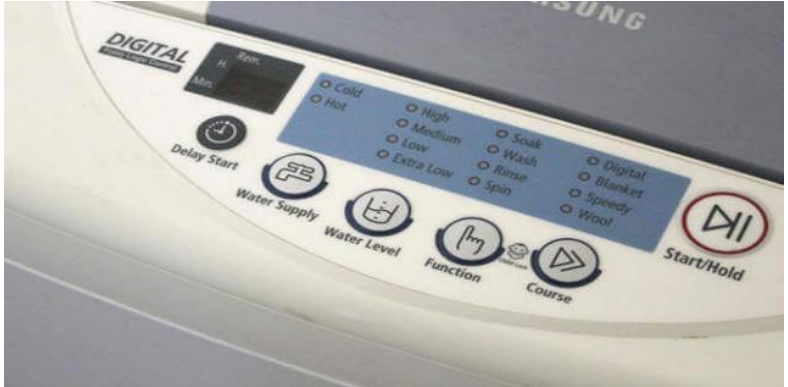
Figure 1. Digital display. Fuzzy logic control.